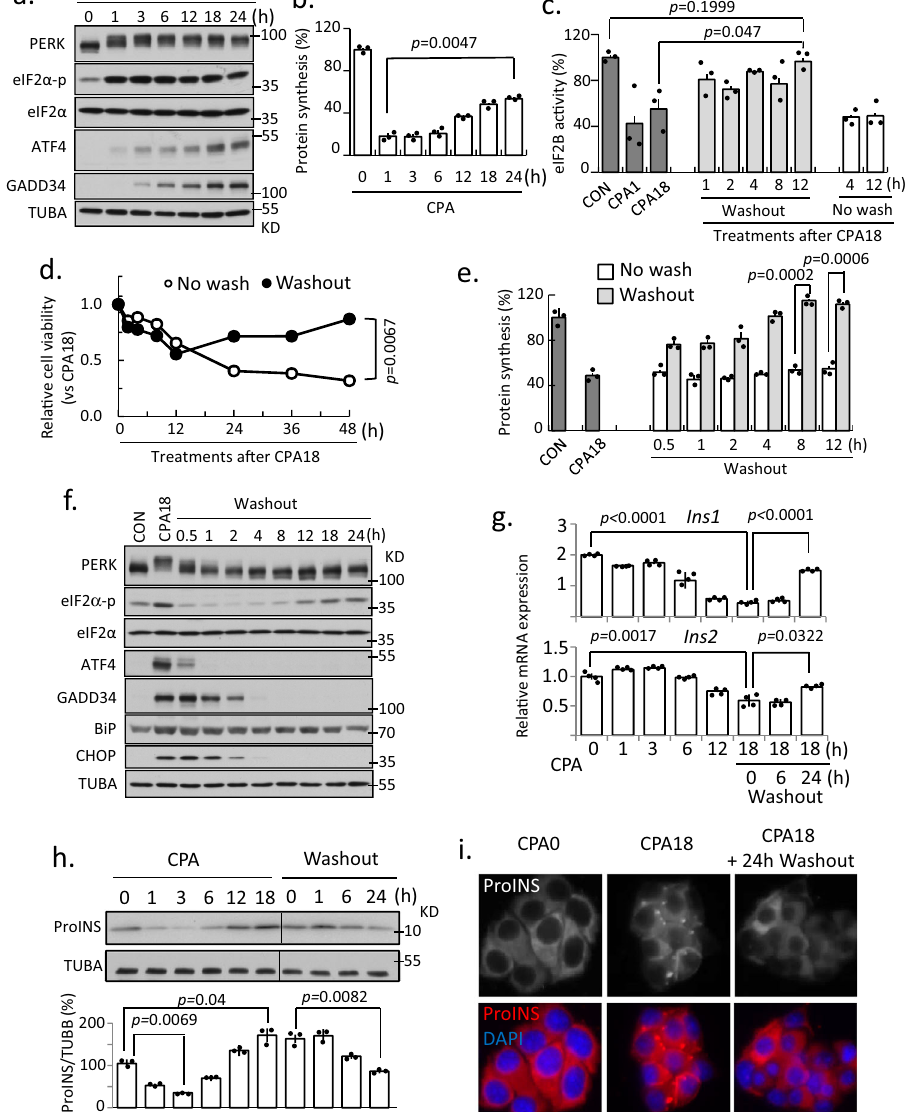
Fig. 1 | MIN6 cells can simultaneously survive chronic ER stress and alter proinsulinproteostasis. Westernblotanalysis( a ),proteinsynthesis, n =3( b ),and eIF2B GEF activity, n =3 ( c ), measured in MIN6 cells treated with CPA as indicated. Cellviability( d ),proteinsynthesis, n =3( e ),andWesternblotanalysis( f )measured inMIN6cellsfortheindicatedtreatments.qRT-PCRanalysisfor Ins1andIns2 mRNA levelsnormalizedto GAPDH,n =3( g ),andWesternblotanalysisforproinsulin, n =3 ( h ), measured in MIN6 cells for the indicated treatments. i Fluorescence